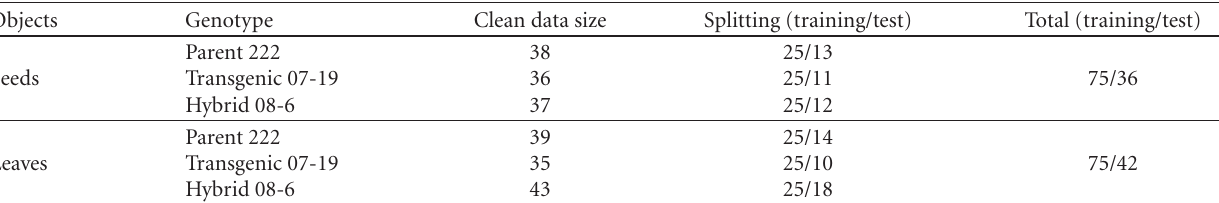
Table 3: Splitting of data with outliers waded into training and test